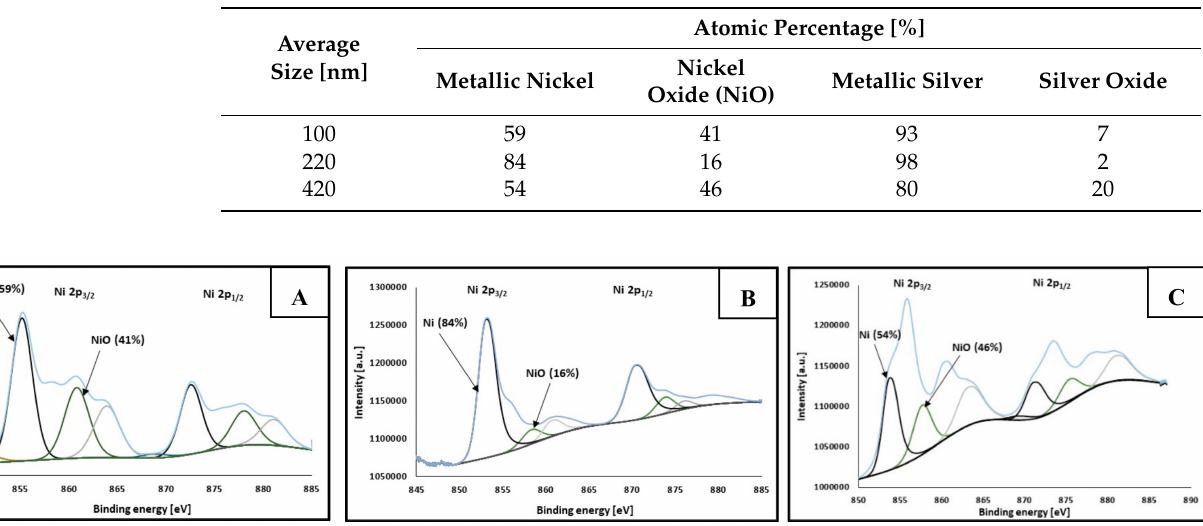
Figure 6. Absorbance spectra of Ni NPs (black curve) and Ni-Ag NPs at various concentrations of AgNO 3 . Table 2. Chemical composition of synthesized Ni-Ag NPs according to XPS.